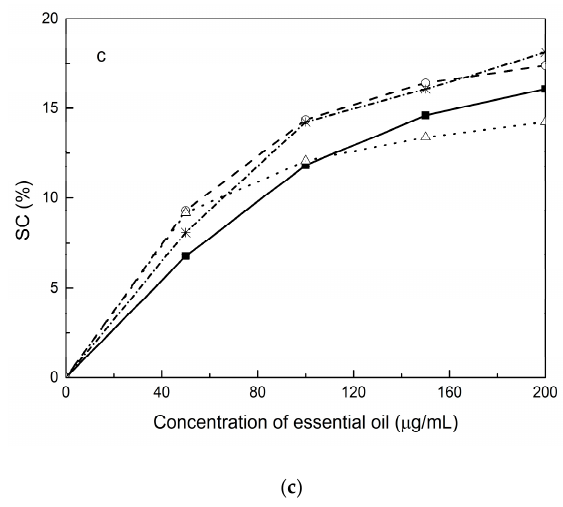
Figure 12. Antioxidant abilities of essential oils: ( a ) DPPH free radical scavenging activity of essential oils, ( b ) FRAP ferric-reducing antioxidant power of essential oils, and ( c ) β -carotene scavenging capacity of essential oils.